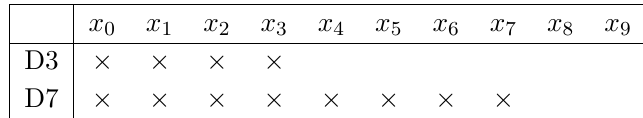
Table 1. The D-brane intersection we consider. The N c D3-branes giving rise to SU( N c ) N = 4 SYM are placed along the directions labelled ( x 0 , . . . , x 3 ) . The N f D7-branes placed along ( x 0 , . . . , x 7 ) give rise to N = 2 hypermultiplets transforming in the fundamental representation of SU( N c